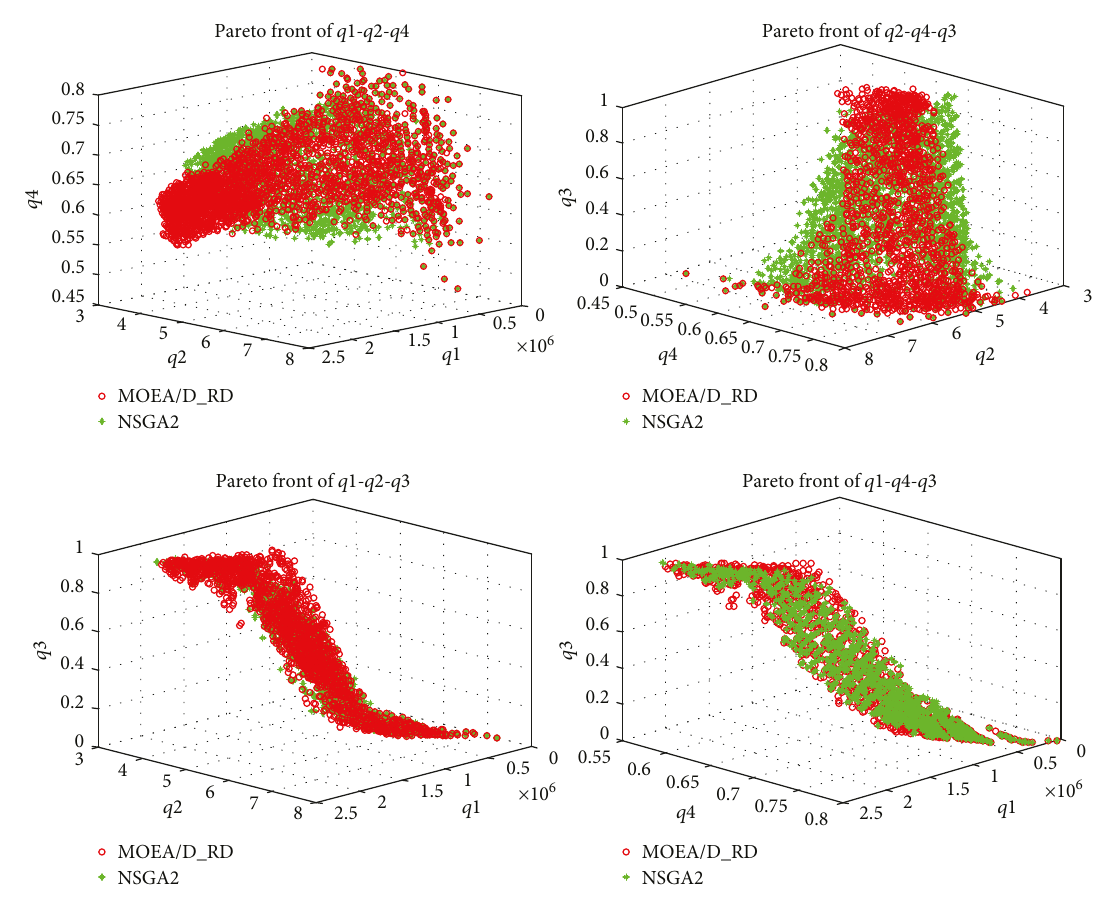
Figure 13: Comparison of PF between MOEA/D_RD (red circle) and NSGA2 (green ∗ ) for 3-objective optimization. Table 4: Comparison of C -metric of MOEA/D_RD and NSGA2. Table 5: Comparison of IGD-metric of MOEA/D_RD and